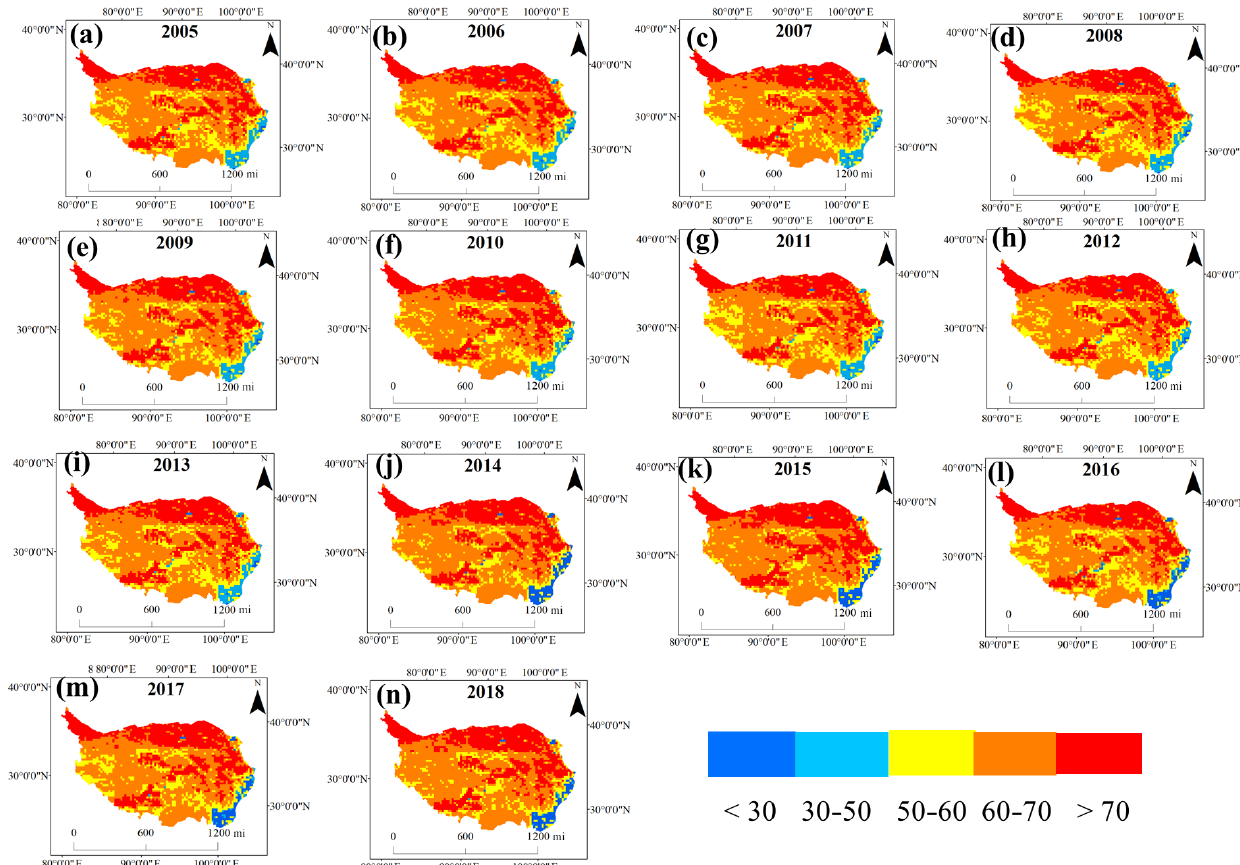
Figure 7. The inter-annual variation in predicted 8h O 3 level (µgm − 3 ) from 2005 to 2018 across the Tibetan